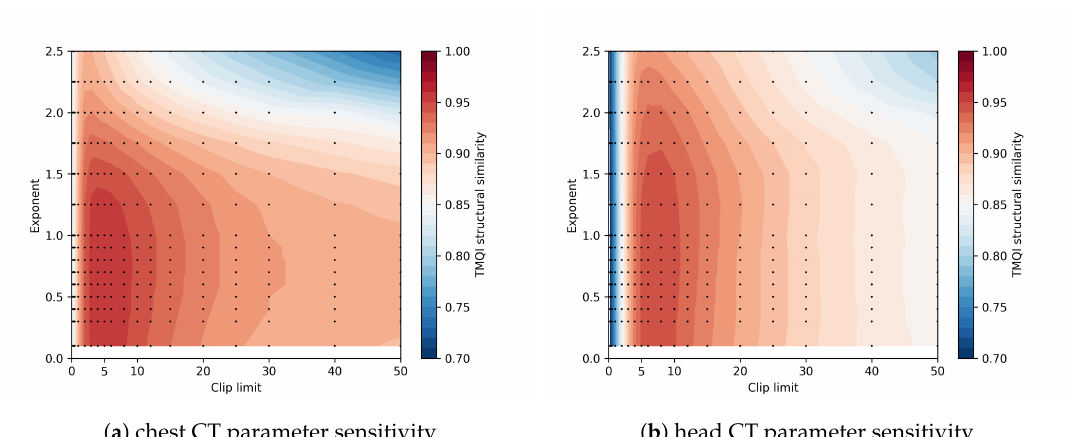
Figure 10. Parameter sensitivity of the algorithm for ( a ) the chest CT, and ( b ) the head CT